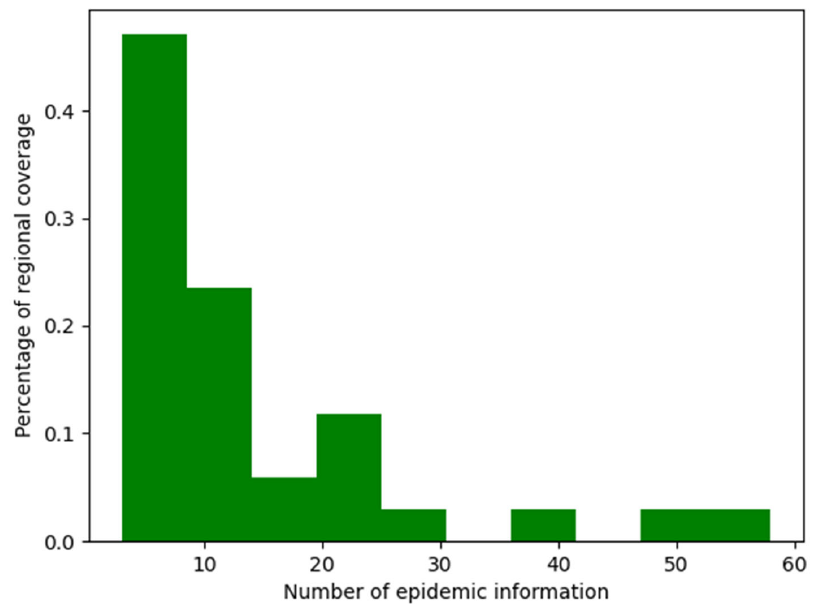
Figure 6. Regional coverage of epidemic information in China.